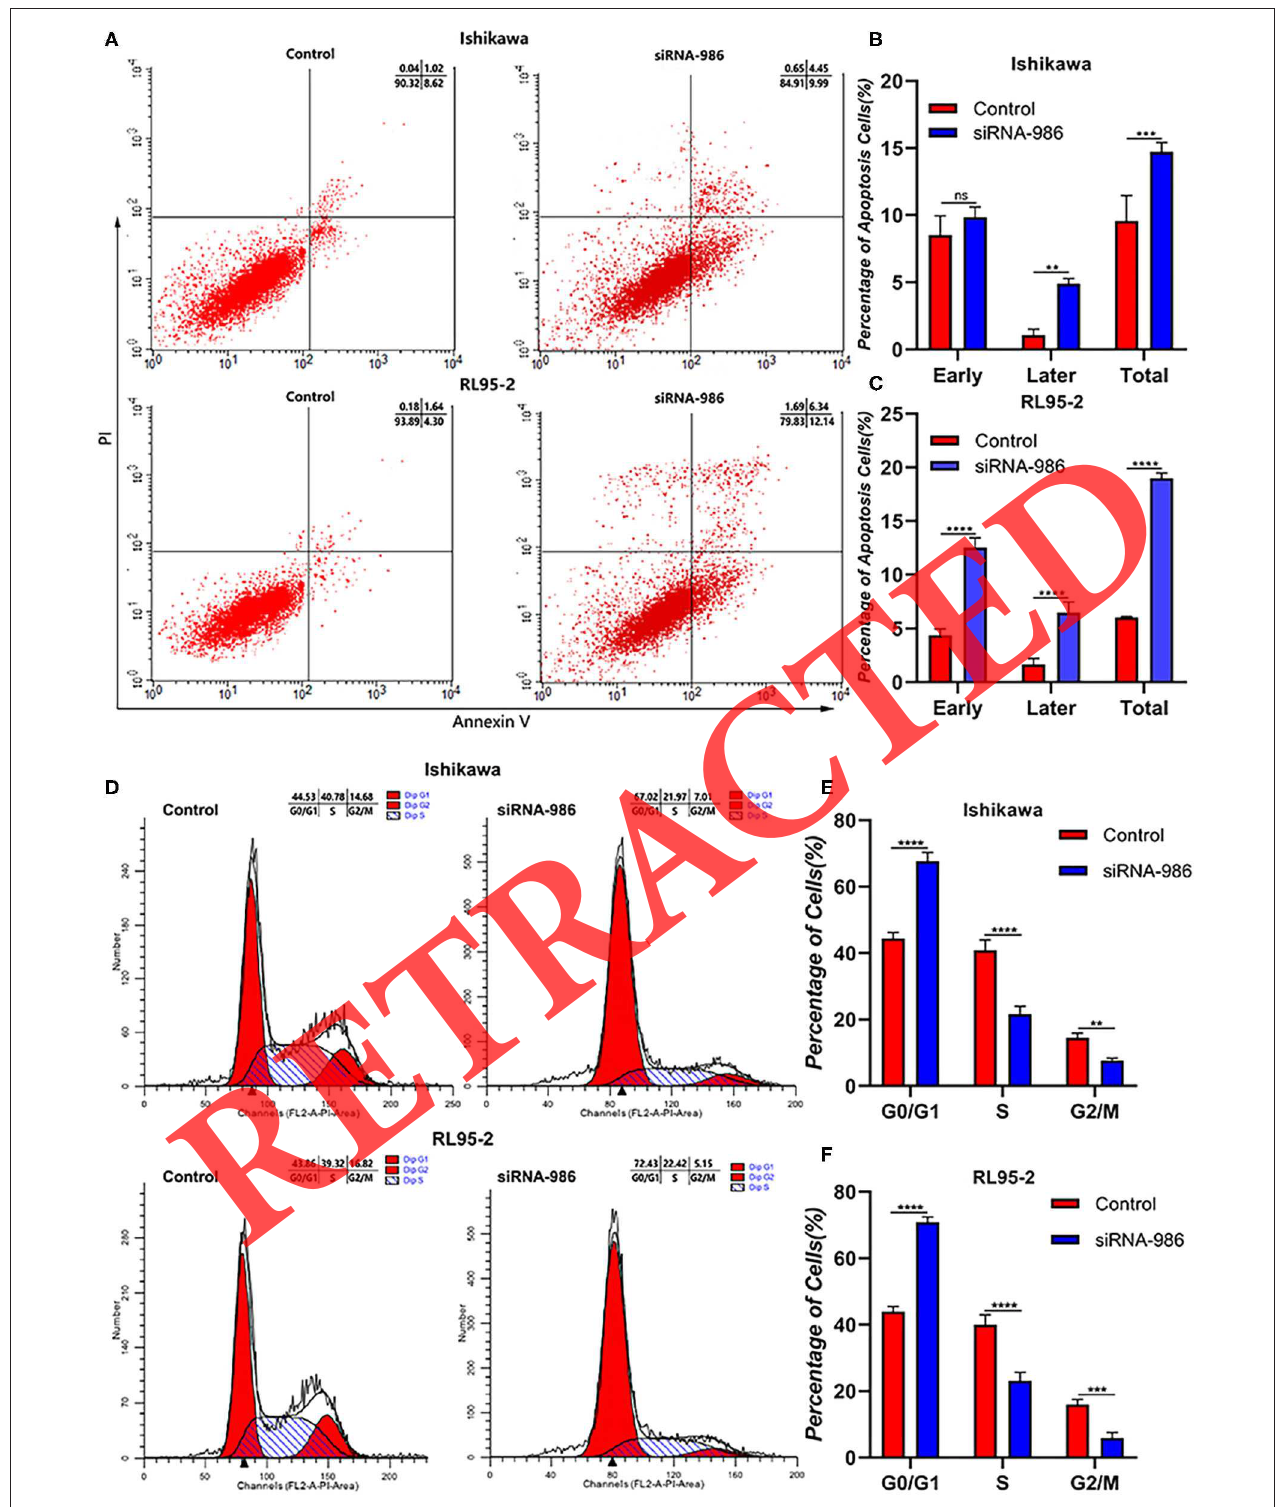
FIGURE 3 | Loss of CCT7 Increased the Tumor Cells Apoptosis and Decreased G2/M Phase of Cells. Cell apoptosis (A–C) and cycle (D–F) of Ishikawa and RL95-2 cells treated with CCT7 siRNA-986 were detected by FAC Scan. ** p < 0.01, *** p < 0.001, **** p < 0.0001, all values represent Mean ± S.D.